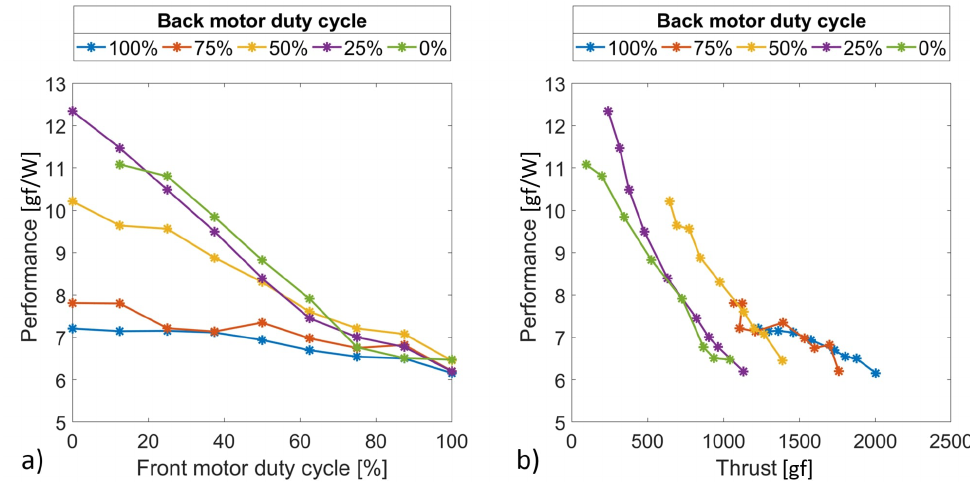
Figure 8. System performance values for different back motor duty cycles against ( a ) Front motor duty cycle and ( b ) Total thrust